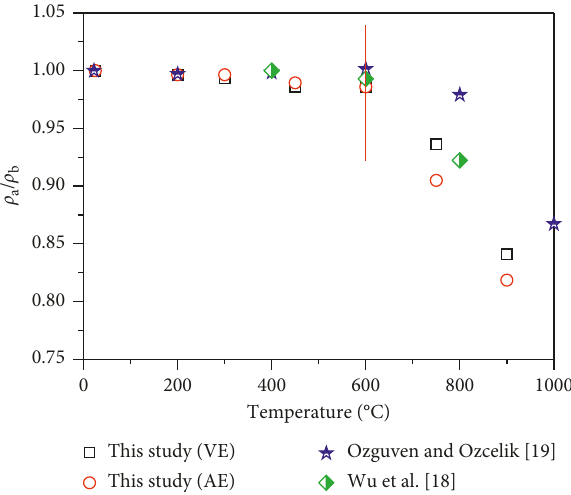
Figure 6: Effect of temperature on ρ